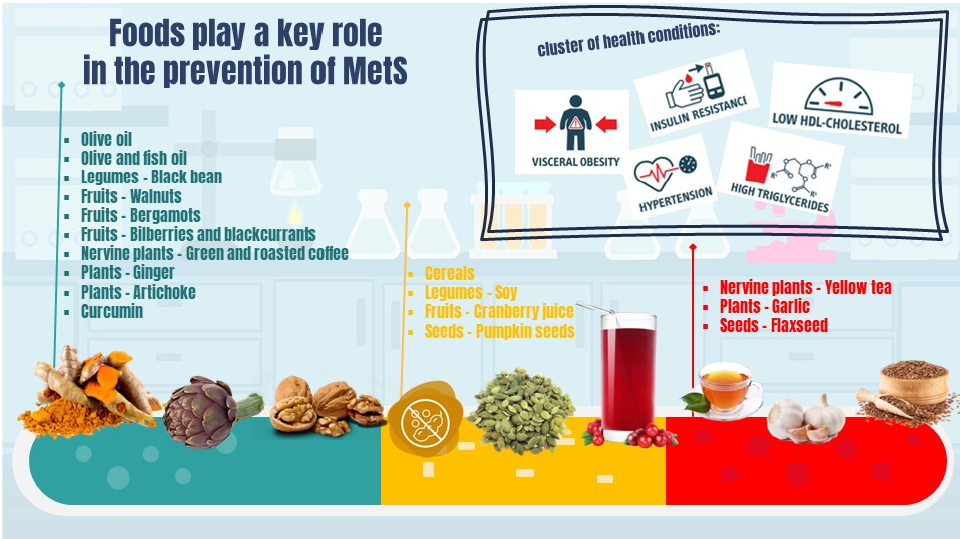
Figure 2. The role of foods and food components in